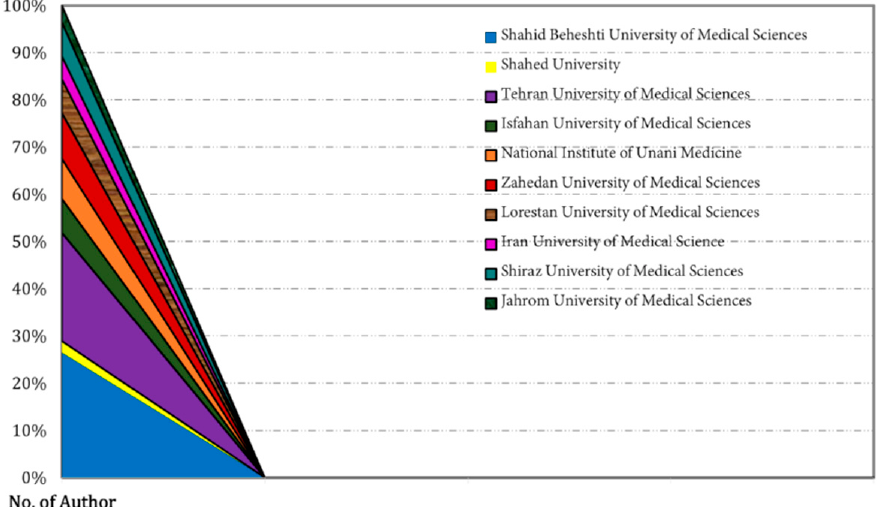
Figure 12. Author distribution as per university-wise related to published RCTs on nutritional supplements and herbal medicine in PMS.